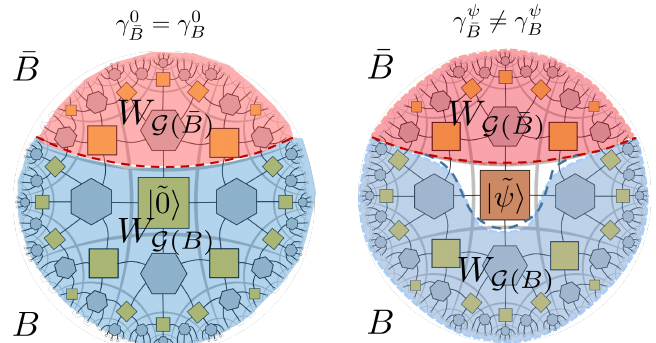
Figure 6. Changes in the bulk state induce changes in the emergent geometry as defined by the entanglement wedge and the Greedy geodesic. Geodesics γ B , γ ¯ B are anchored on the same two boundary